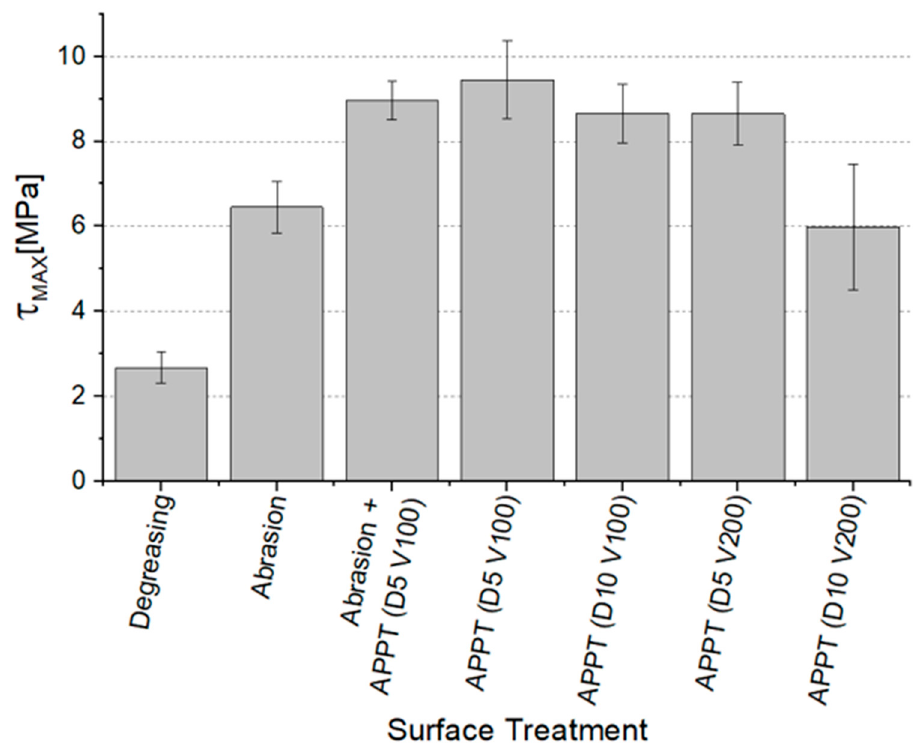
Figure 7. Average value and standard deviation of apparent shear strength for every set of speci- mens.